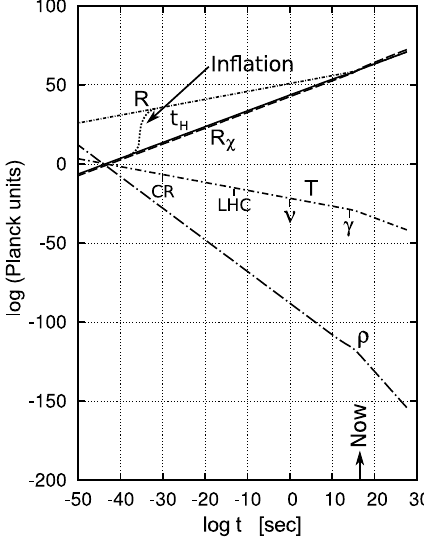
Fig. 1. Evolution of the hyperbolic Big-Bang Universe. R { radial coordinate, t H { Hubble age, R (cid:31) { particle horizon, T { temperature, CR { maximal energy cosmic rays, LHC { Large Hadron Collider, (cid:23) { neutrino decoupling, (cid:13) { photon decoupling, (cid:26) {